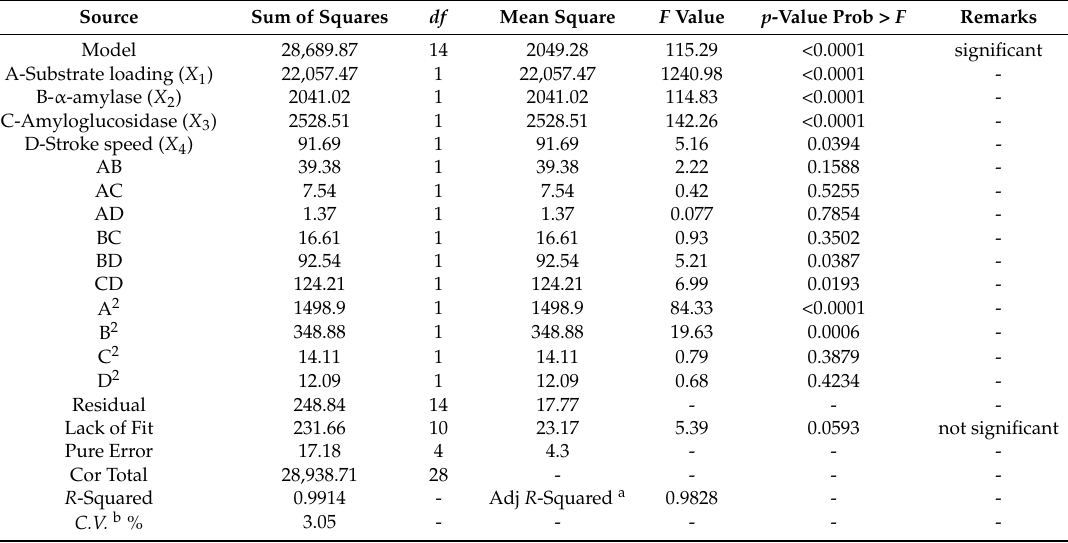
Table 4. Analysis of variance (ANOVA) results for the starch hydrolysis process. C.V. : coefficient of variation.